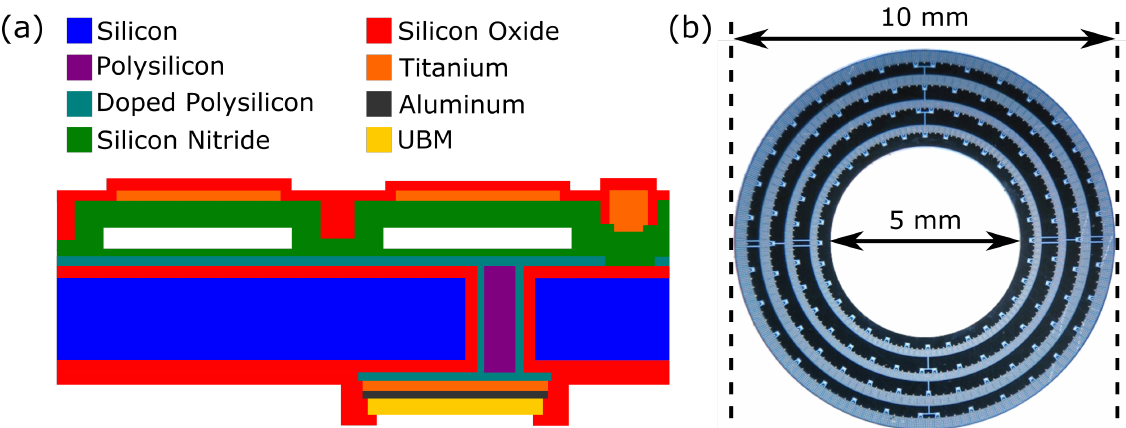
Figure 7. ( a ) Structure of a sacrificial release CMUT with vias for backside electrical contacts. ( b ) A four-ring 2D CMUT array fabricated using a sacrificial release process and through-wafer vias, as decribed in